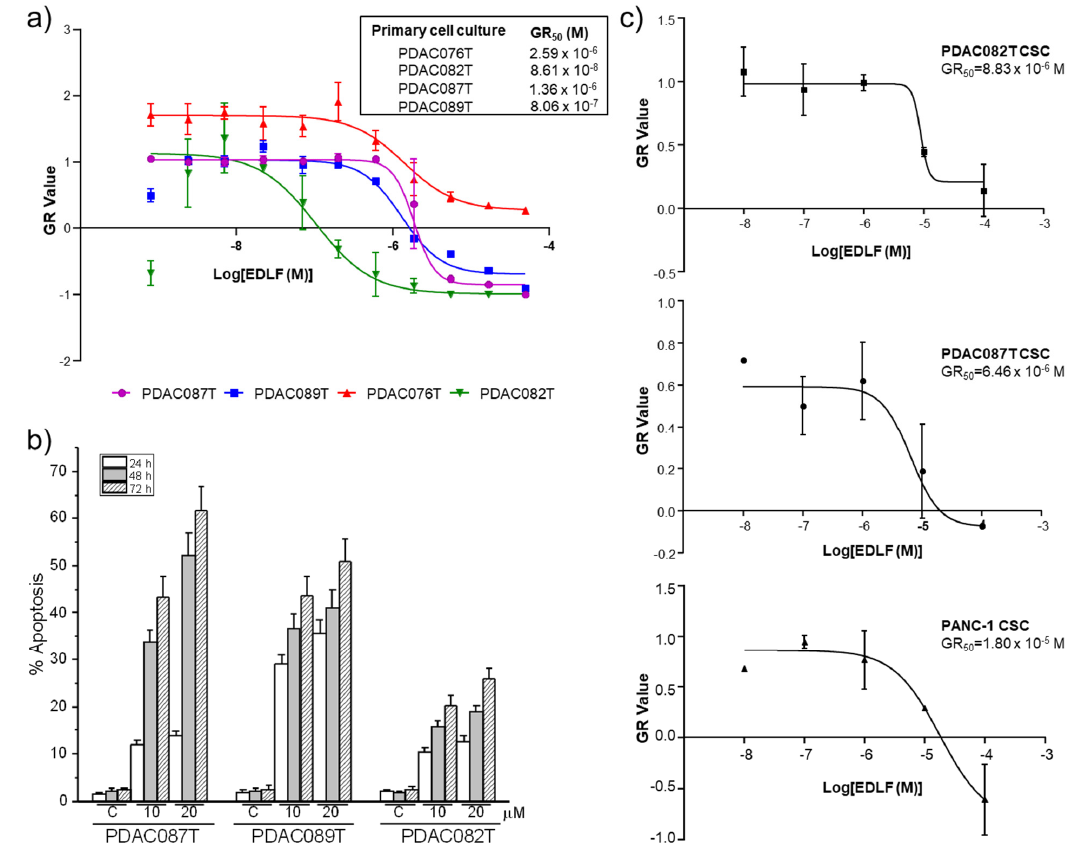
Figure 7. Characterization of the chemosensitivity profile after edelfosine treatment in human pancreatic cancer primary cultures. ( a ) Four different PDAC-derived primary cell cultures were treated with increasing concentrations of edelfosine (EDLF), and the ability to inhibit cell proliferation was measured after 72 h of treatment. The growth inhibition rate was calculated applying the GR metrics R package. The data represent the means ± SD of the GR metric scores. GR 50 values for each pancreatic cancer primary culture are shown (inset). ( b ) Induction of apoptosis in human pancreatic cancer primary cultures by edelfosine treatment. PDAC087T, PDAC089T and PDAC082T were incubated with 10 and 20 µ M edelfosine for the indicated incubation times, and the percentage of apoptosis was then determined by means of flow cytometry, as assessed by the increase of cells in the sub-G 0 /G 1 region. Untreated control cells were run in parallel. The data are shown as the means ± SD of three independent experiments. ( c ) Effect of edelfosine on the proliferation capacity of CSC pancreatic cancer spheroids generated from PDAC082T, PDAC087T and PANC-1. The cells were incubated with different concentrations of edelfosine for 72 h. Growth inhibition was analyzed by using the GR metrics as above, and the GR 50 values are shown. The results shown are the means ± SD of three independent experiments performed in